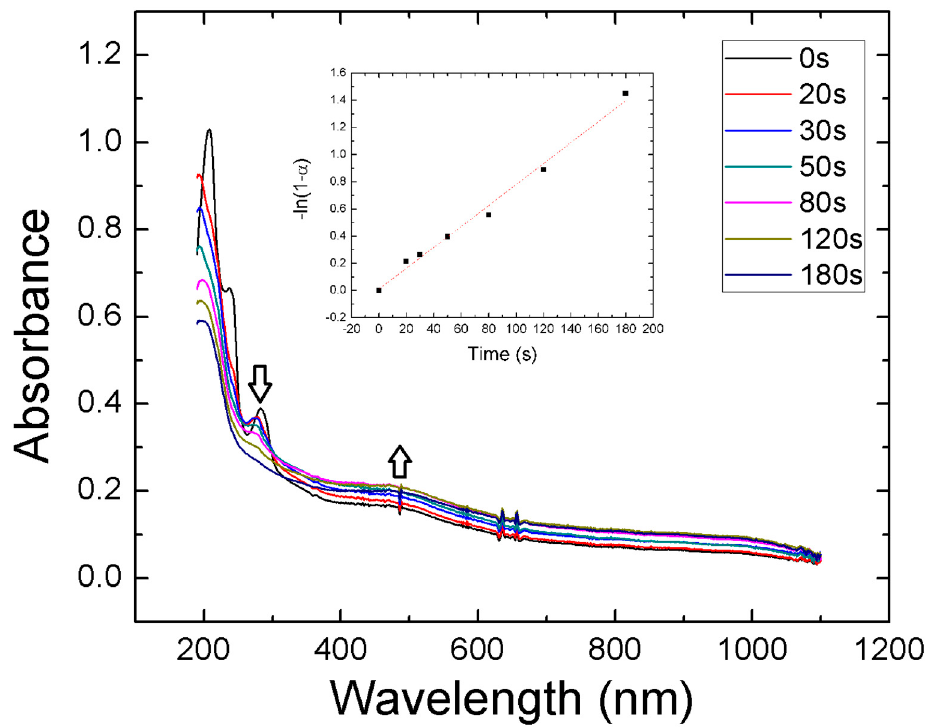
Figure 4. UV-visible absorbance of o-aminophenol films on a high-density polyethylene substrate treated with DBD for di ff erent durations of time. Graph plotted according to the solid-state reaction for the first order models at 283 nm vs. time. The arrows show the direction of intensity changes of the peaks at 490 nm and 283 nm during the plasma treatment.